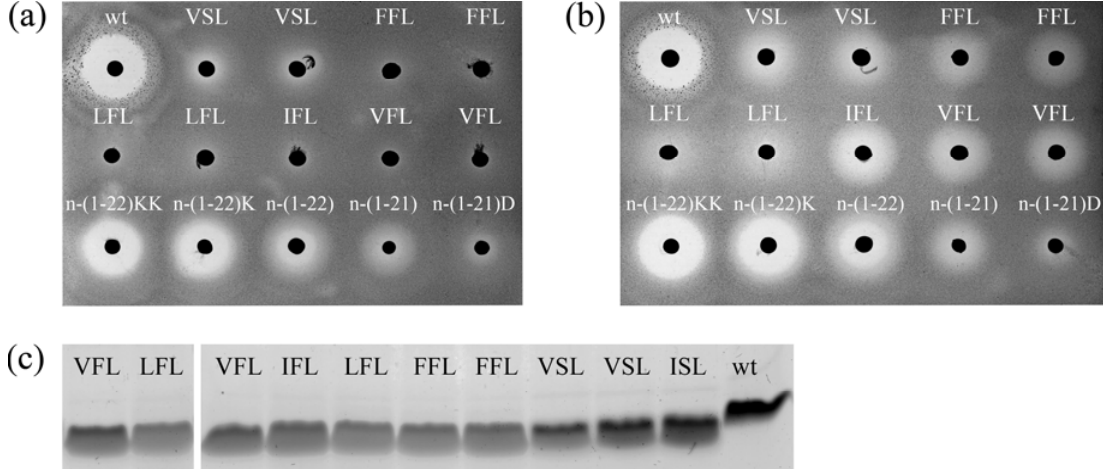
Figure 2. Antimicrobial activity and production of truncated nisin analogs. The three amino acids correspond to residues 4, 5 and 6 and were obtained by genetic randomization and screening for activity. Nisin- is abbreviated to n-. (a) Growth inhibition of L. lactis pNGnisT pNGnisP by colonies producing prenisin-(1-22) ring A mutants (first two rows) and colonies producing truncated prenisin analogs containing C-terminal amino acid substitutions or additions (last row), without nisin induction and (b) with nisin induction. (c) Production levels of prenisin-(1-22) ring A mutants analyzed on a tricine SDS gel. ISL is wild type prenisin-(1-22); wt denotes full length wild type prenisin.